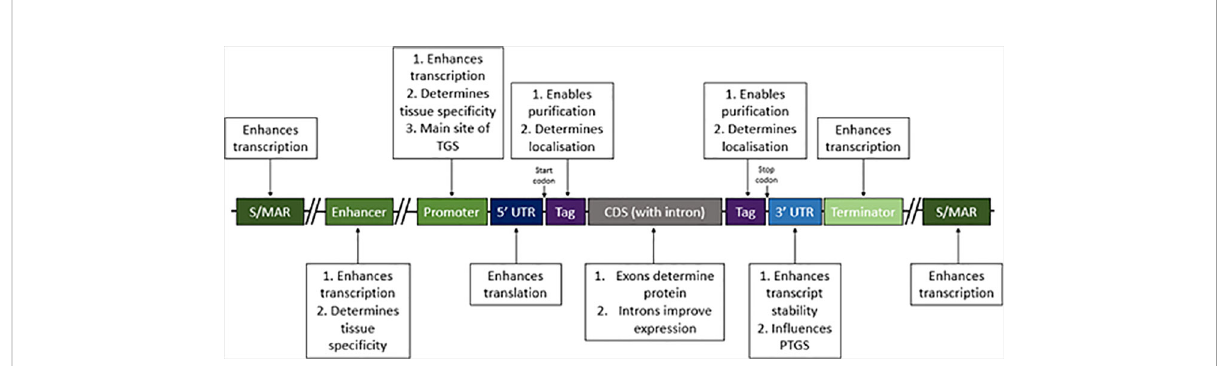
FIGURE 1 Regulatory DNA elements to consider when making plant RP expression constructs. Some DNA elements are essential in expression constructs, including a promoter, the coding sequence (CDS) and terminator; however many components in expression constructs are non-essential, including scaffold/matrix attachment regions (S/MARs), enhancers, introns, tags and to some extent untranslated regions (UTRs). Each of these elements has implications in recombinant protein expression, by affecting either transcription, translation, stability or ef fi cacy of puri fi cation. The main roles of each element are summarised in this fi gure and should be considered when designing RP expression